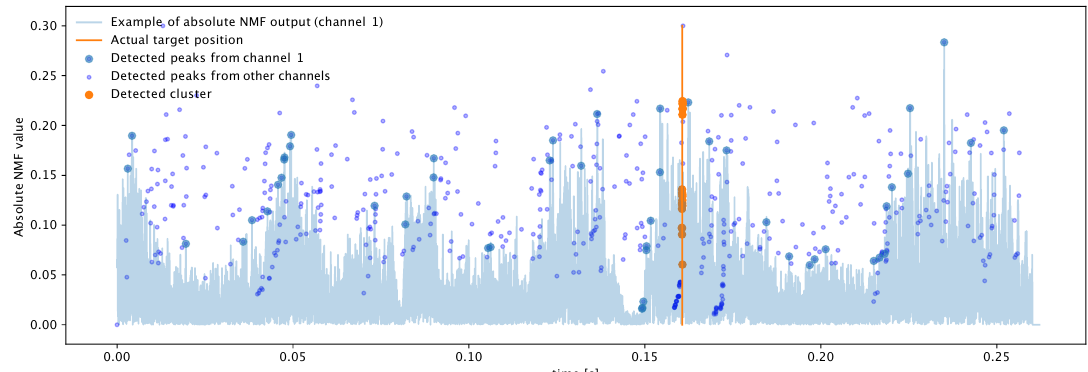
Figure 2. Example of successful DBSCAN clustering for peaks collected by a 10-element array. The light-blue time series is the output of the NMF for channel 1. Large blue circles represent peak detections for this NMF time series. Smaller dark-purple peaks represent peak detections from the remaining nine channels. DBSCAN correctly detects a cluster of target related arrivals around 0.16 s (vertical orange line). Data from a real lake